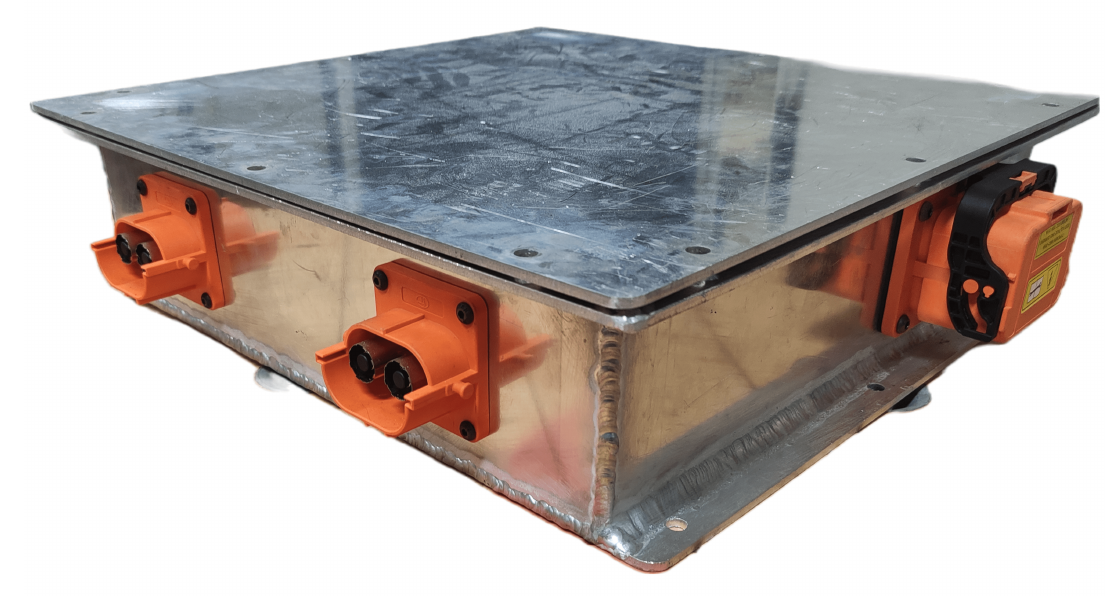
Figure 18. High Voltage Distribution Unit (HVDU).